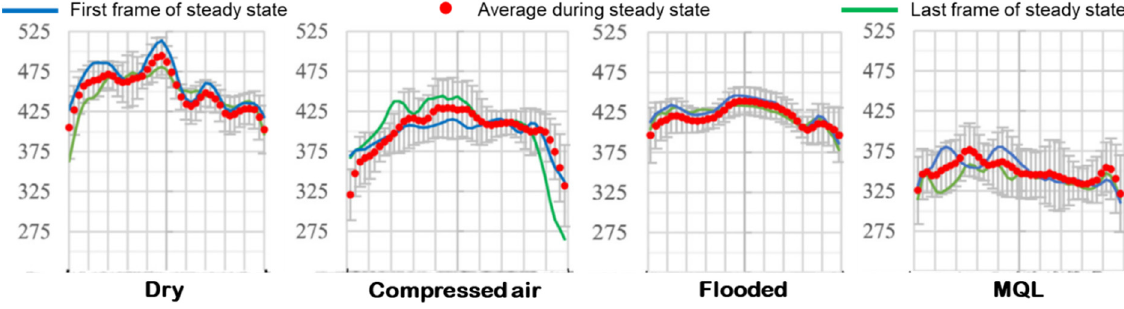
Figure 11. Temperature signal at cutting zone under different cooling lubrication methods (v = 111 m/min, f = 0.24 mm/rev). (v = 111 m/min, f = 0.24